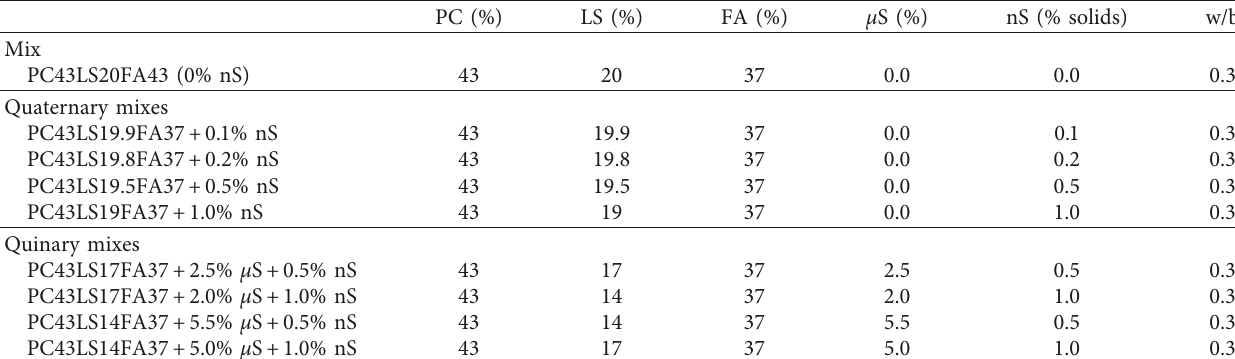
Figure 2: GnS carboxylic solution and LnS aqueous solution. Table 2: Mix proportions (%) by total mass of